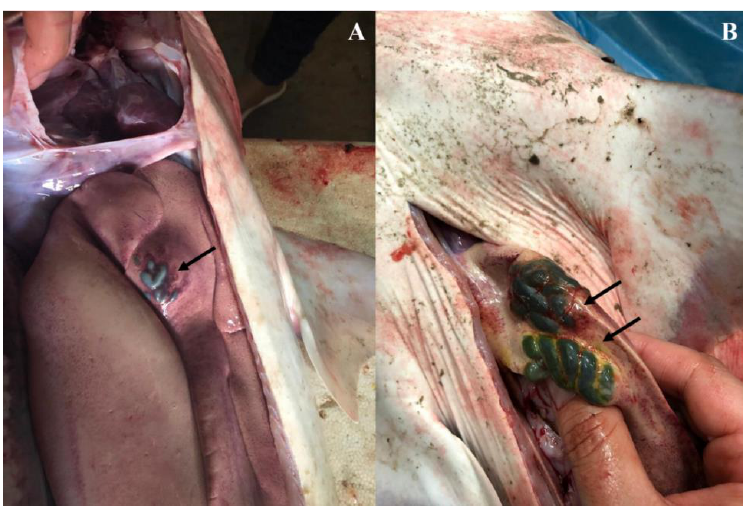
Figure 2. Clusters of bile-filled cysts in the left lobe of the liver of two juvenile female tiger sharks. ( A ) Photographic record of juvenile female (SBA1) liver. ( B ) Photographic record of juvenile female (SBA2) liver. Black arrows indicate bile-filled cysts.